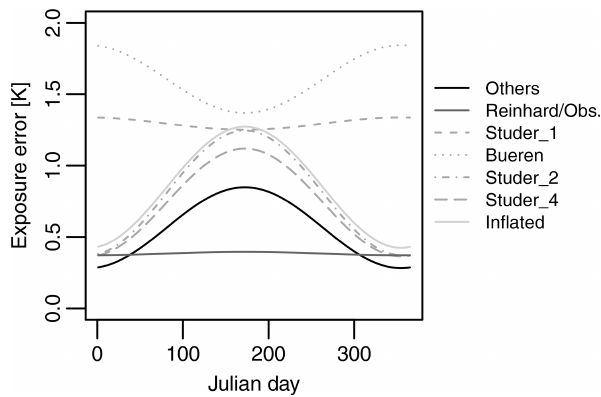
Figure 7. Comparison of different estimations of the exposure error e 4 for n =